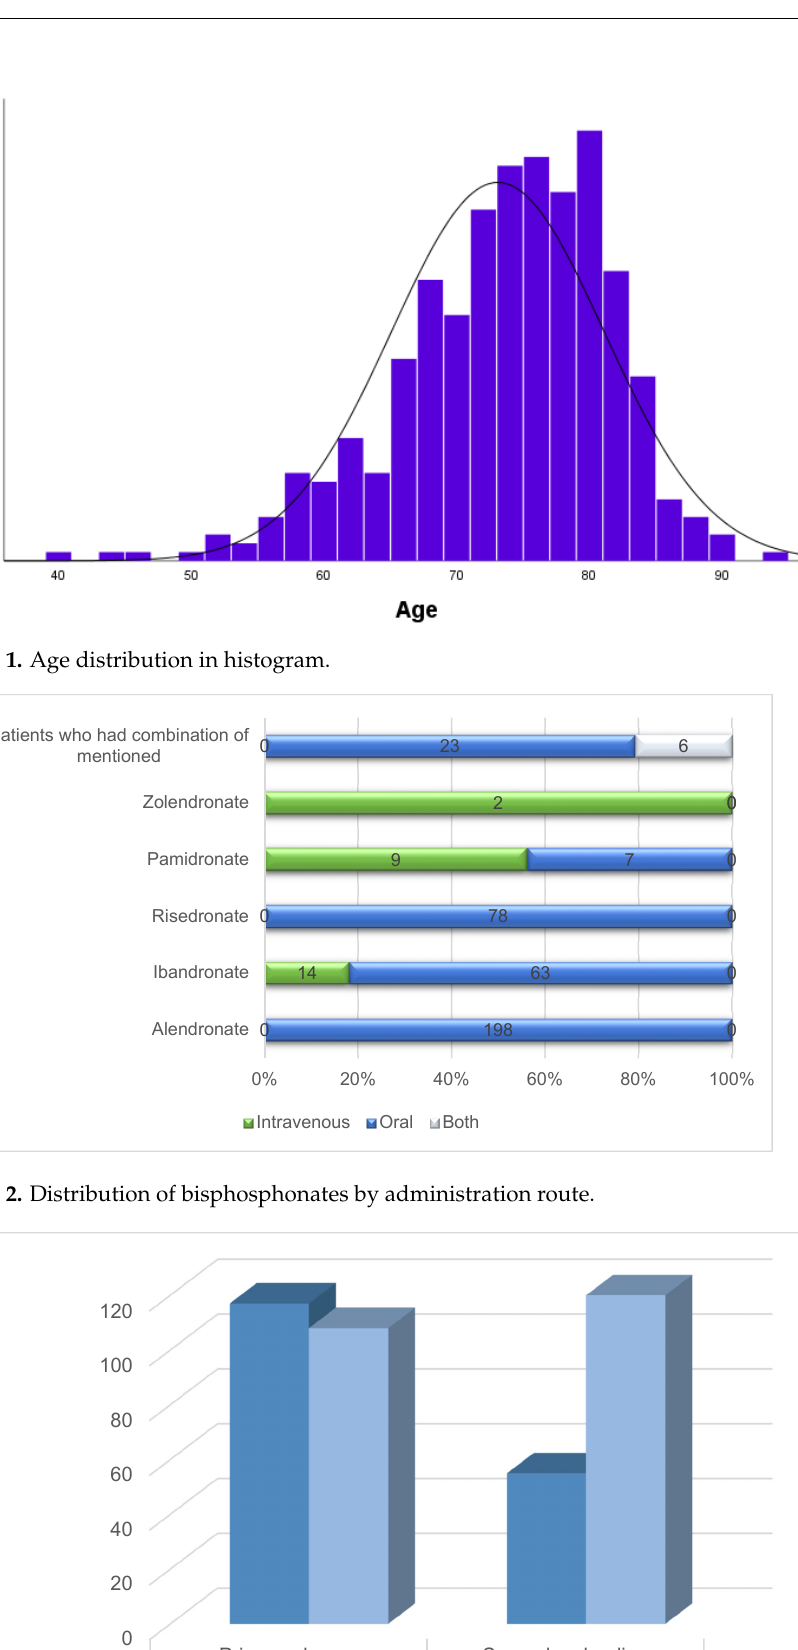
Figure 3. Bone-exposed patients distributed by wound management. Table 1. Descriptive characteristics of the study variables.